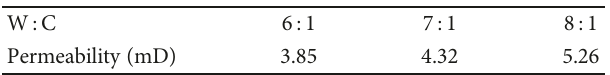
Table 2: Permeability of expandable slurries with high water content sample under con fi ning pressure